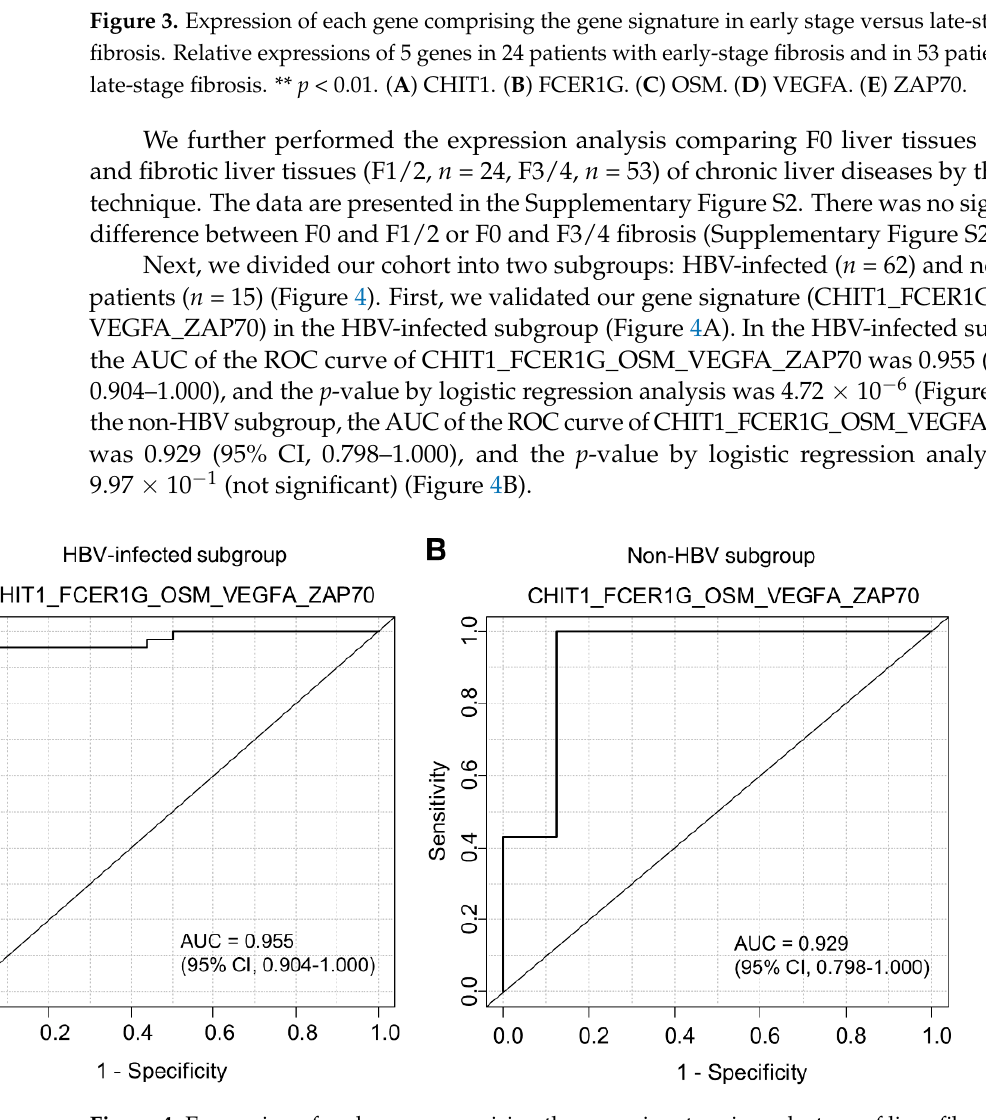
Figure 4. Expression of each gene comprising the gene signature in each stage of liver fibrosis in the HBV (( A ), n = 62) and non-HBV (( B ), n = 15)